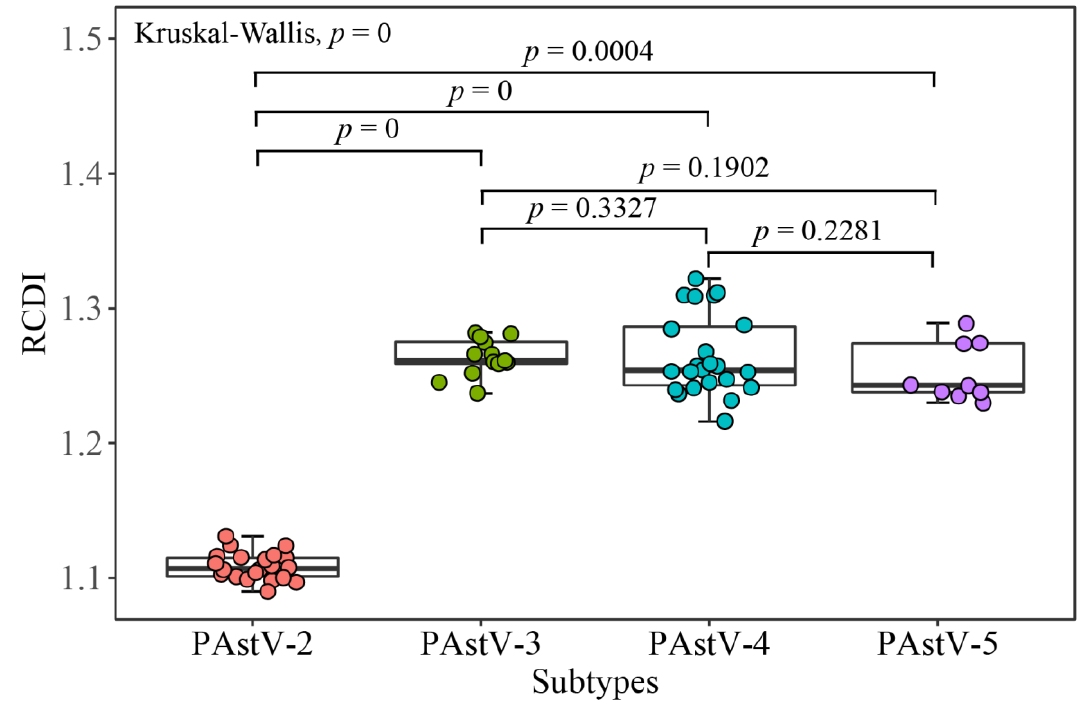
Figure 8. Relative codon deoptimization index (RCDI) of the PAstV complete coding genomes. PAstV-2, PAstV-3, PAstV-4, and PAstV-5 strains are represented in orange, green, blue, and purple, respectively.